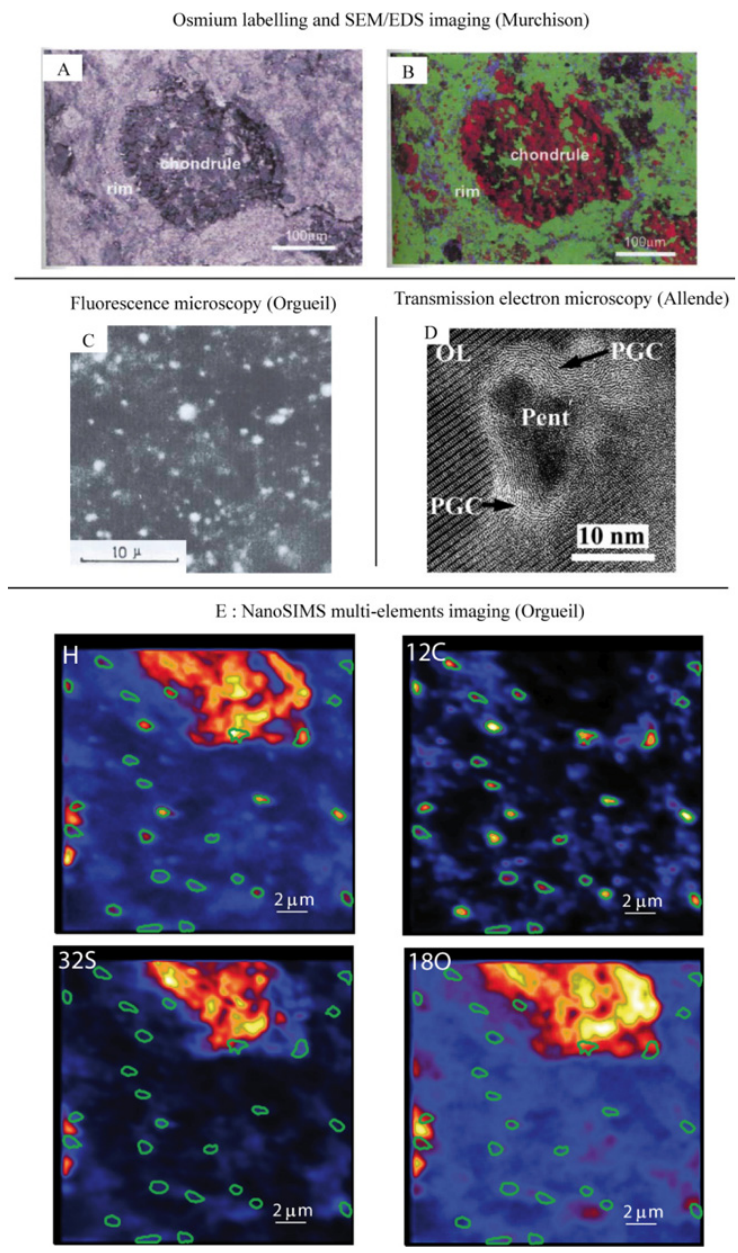
Figure 4. Location of organic matter in chondrites revealed by several techniques (the name of the corresponding meteorite is indicated into brackets). A and B: Osmium labelling reveals that organic matter occurs in the matrix, the chondrule being free of organic matter [81]. C: By fluorescence microscopy, organic matter (white structures) appear as isolated particles, with sizes ranging from 0.5 up to 4 microns randomly distributed in the matrix [82]. This is consistent with NanoSIMS imaging (E). Organic matter corresponds to area rich in both C and H. Organic particles are circled in green, and show no association with a big mineral rich in S, O and H (sulfate). But, at the nanometer scale [83], as what is observed by TEM (D), organic matter (called PGC: poorly graphitized carbon) forms coatings around sulfides (Pent: pentlandite). Ol: Olivine grain, abundant in the matrix of this kind of chondrite.